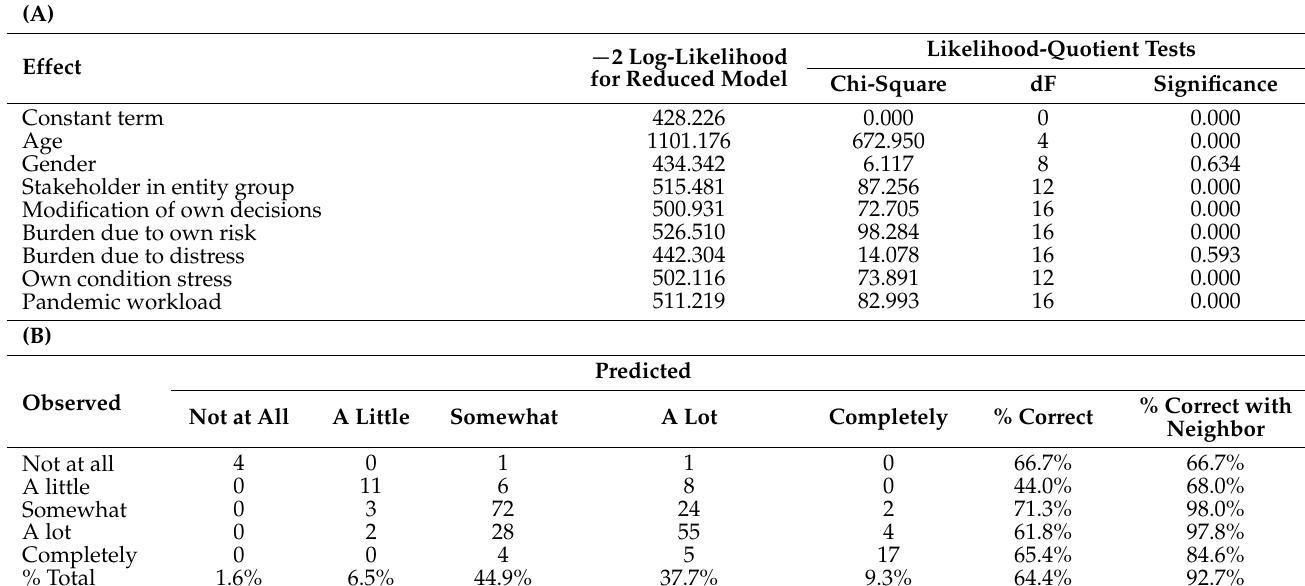
Table 3. Prediction by nominal regression analysis for “Decisional Conflicts”: (A) Likelihood– Quotient Test for regression parameters and (B) resulting